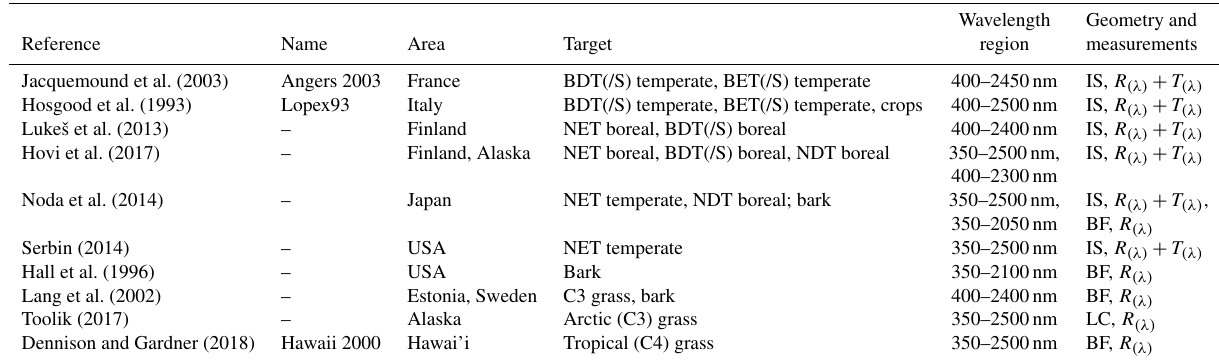
Table 2. Spectral data used in this study. This table only lists data properties that were used in this study (i.e., the datasets may contain other data collected using different devices or methods or from different targets). Abbreviations: IS – integrating sphere; LC – leaf clip; BF – bare optical fiber or optical head of spectrometer; R (λ) – reflectance spectra; T (λ) – transmittance spectra. Target BDT(/S) contains both BDT and BDS PFTs for temperate and boreal regions, and similarly “BET(/S)” contains both BET and BES PFTs.